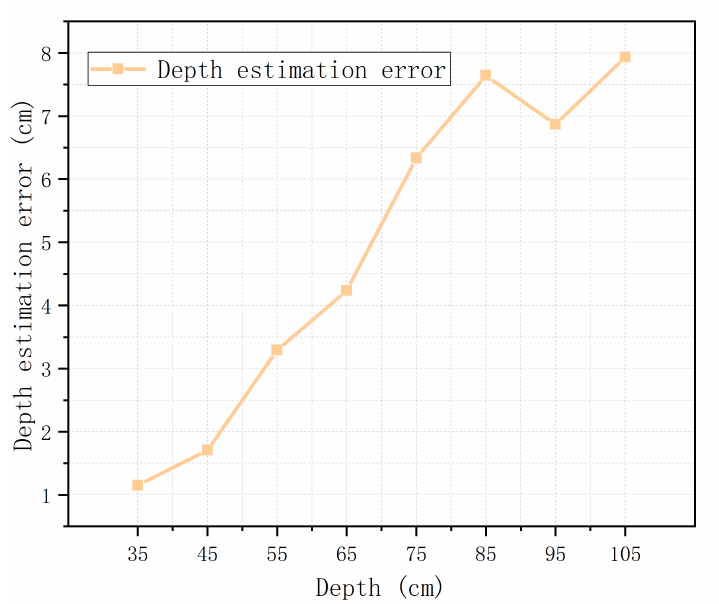
Figure 10. Depth estimation error of a cylindrical target at different